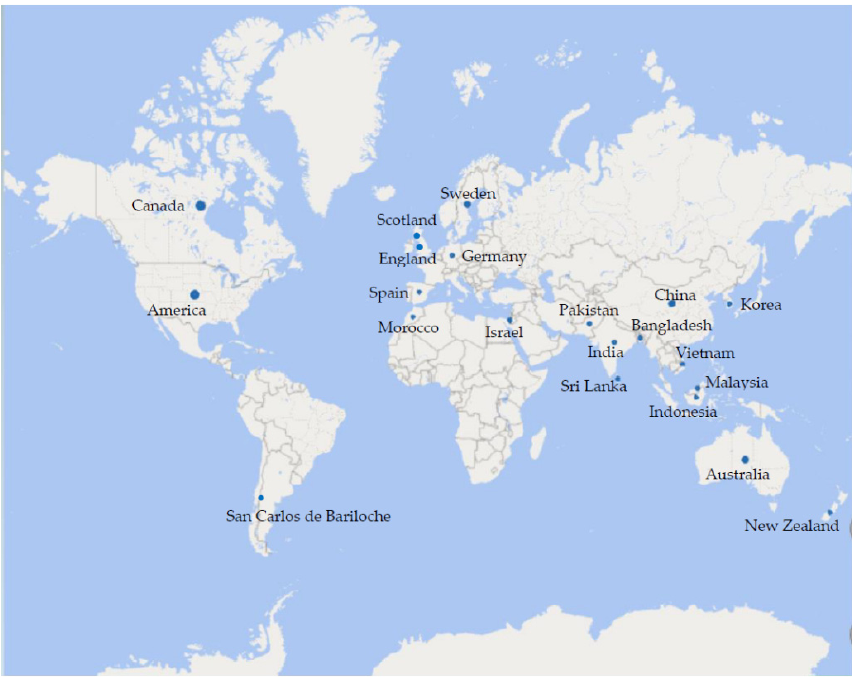
Figure 2. Countries involved in the included studies.